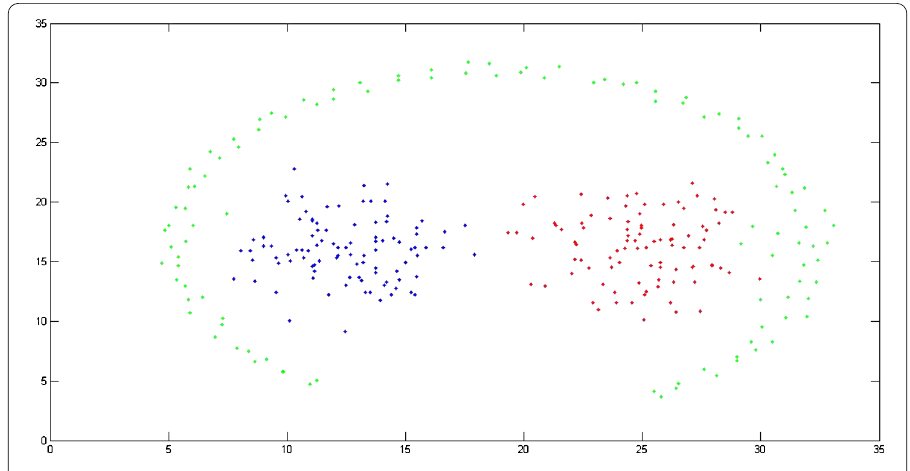
Figure 4 Path-based data set.